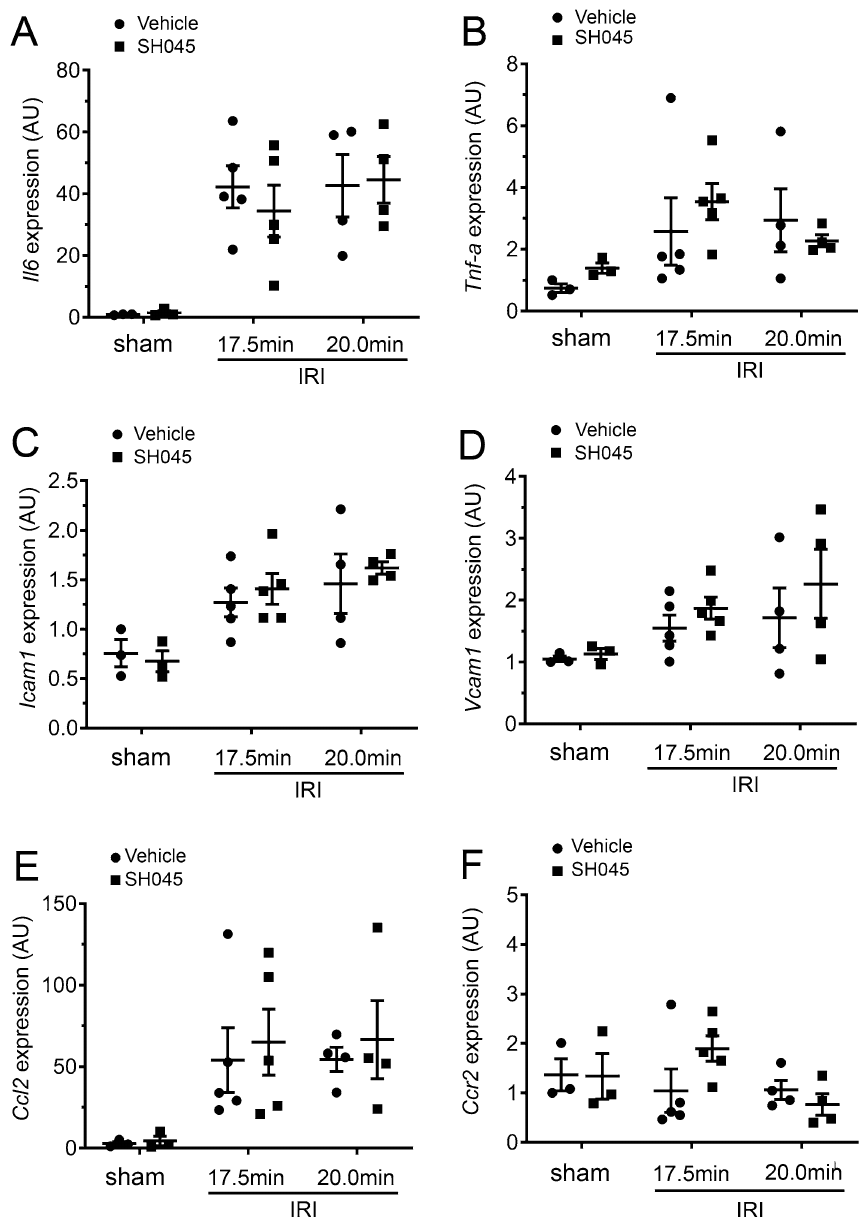
Figure 8. SH045 effects on gene expression of pro-inflammatory cytokines and chemokines after renal IRI. ( A ) Renal mRNA levels of interleukin 6 ( Il 6 ), ( B ) tumor necrosis factor-α ( Tnf-α ), ( C ) intercellular adhesion molecule 1 ( Icam1 ) and ( D ) vascular cell adhesion protein 1 ( Vcam1 ). ( E ) Renal mRNA levels of C–C motif chemokine 2 ( Ccl2 ) and ( F ) C–C motif chemokine receptor 2 ( Ccr2 ). Data expressed as means ± SEM (Sham n = 3 each, 17.5 min-IRI in vehicle and SH045 n = 5 each, 20 min-IRI in vehicle and SH045 n = 4 each, respectively). Two-way ANOVA followed by Sidak’s multiple comparisons post hoc test. AU arbitrary